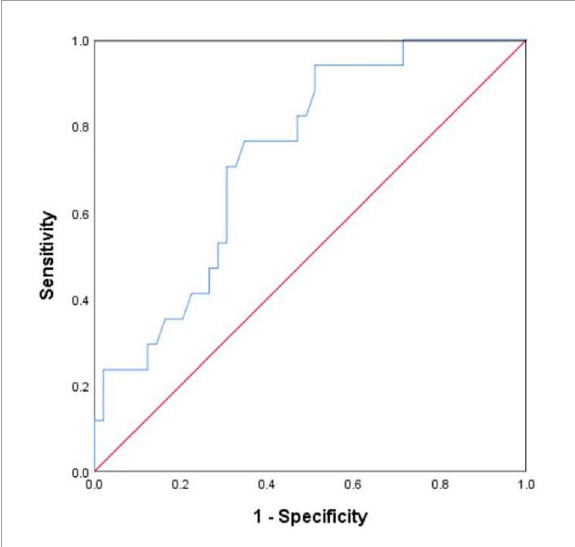
FIGURE2 Receiver operating characteristic (ROC) curve of soluble lymphocyte activation gene- 3 (sLAG3) for identifying coronary artery